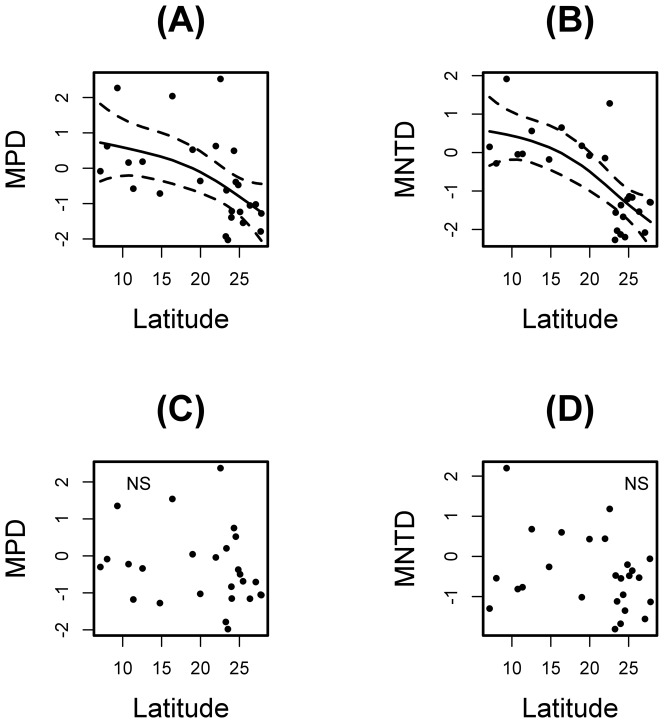
Relationship between morphological structure of the leaf-litter ant fauna along a latitudinal gradient in the Brazilian Atlantic Forest.A–B: unconstrained species pool models for MPD and MNTD, respectively; C–D: constrained species pools models for MPD and MNTD, respectively. Solid line shows the GAM model and the dashed line is the 95% confidence interval.